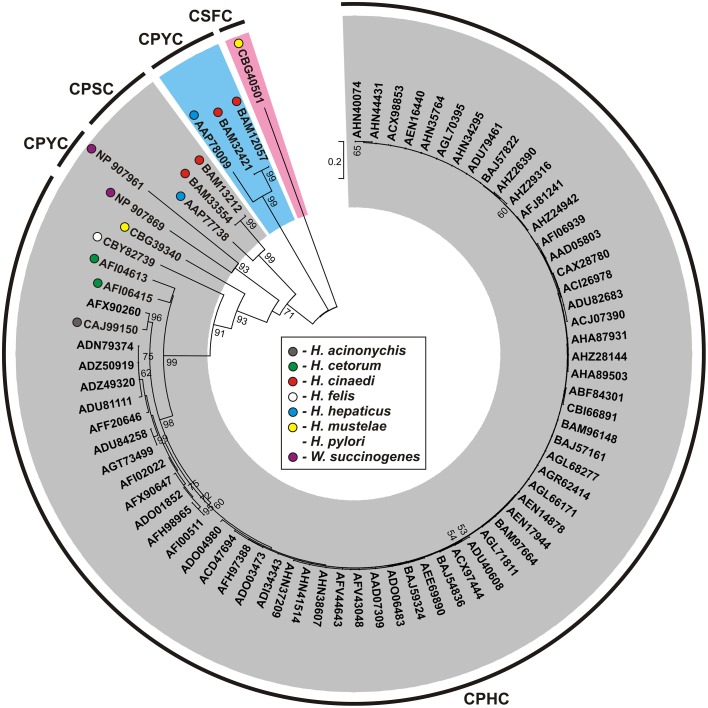
Phylogenetic tree of the HP0231-like proteins of
Helicobacter
spp. and
Wolinella succinogenes
DSM 1740. The analysis was based on 77 protein sequences and 265 amino acid positions (highly variable portions of the alignments were eliminated by the use of G-blocks). The unrooted tree was constructed using the neighbor-joining algorithm. The statistical support for the internal nodes was determined by 1000 bootstrap replicates. Values of >50% are shown. Accession numbers of the protein sequences used for the phylogenetic analysis are given. The three main clusters were distinguished with gray, pink, and blue color, respectively. The conserved catalytic motifs (CXXC) are presented.